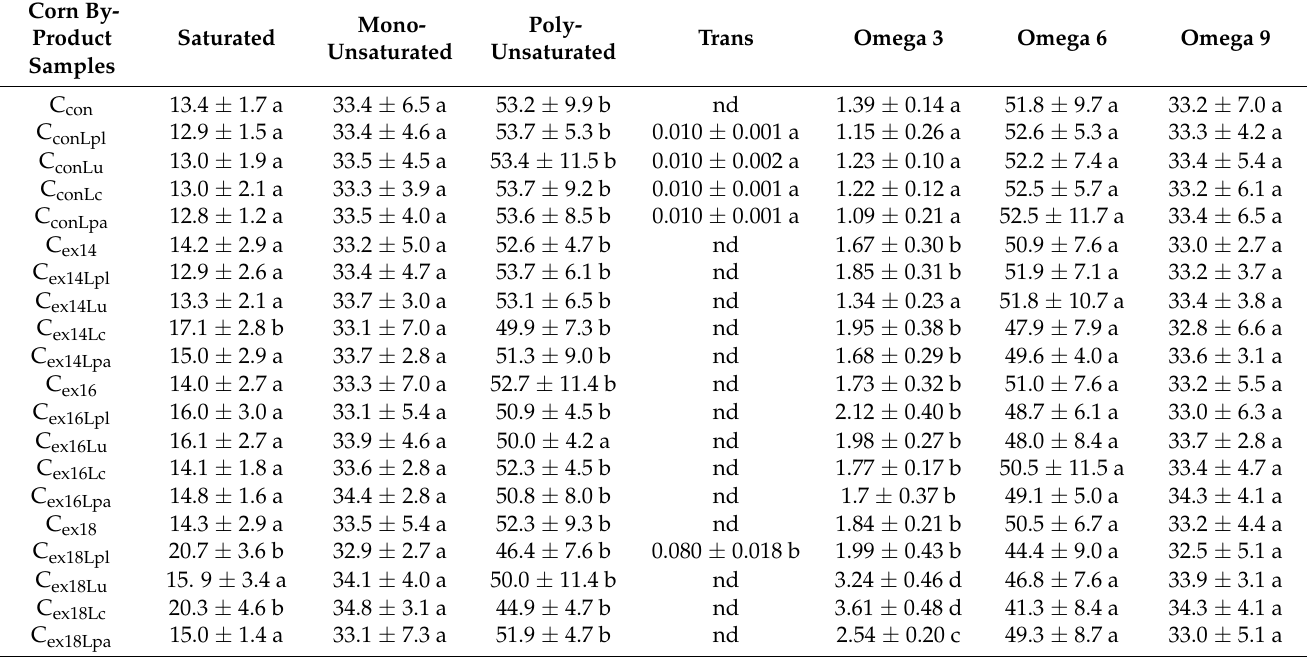
Table 5. The fatty acids percentage profile of the non-treated and treated corn